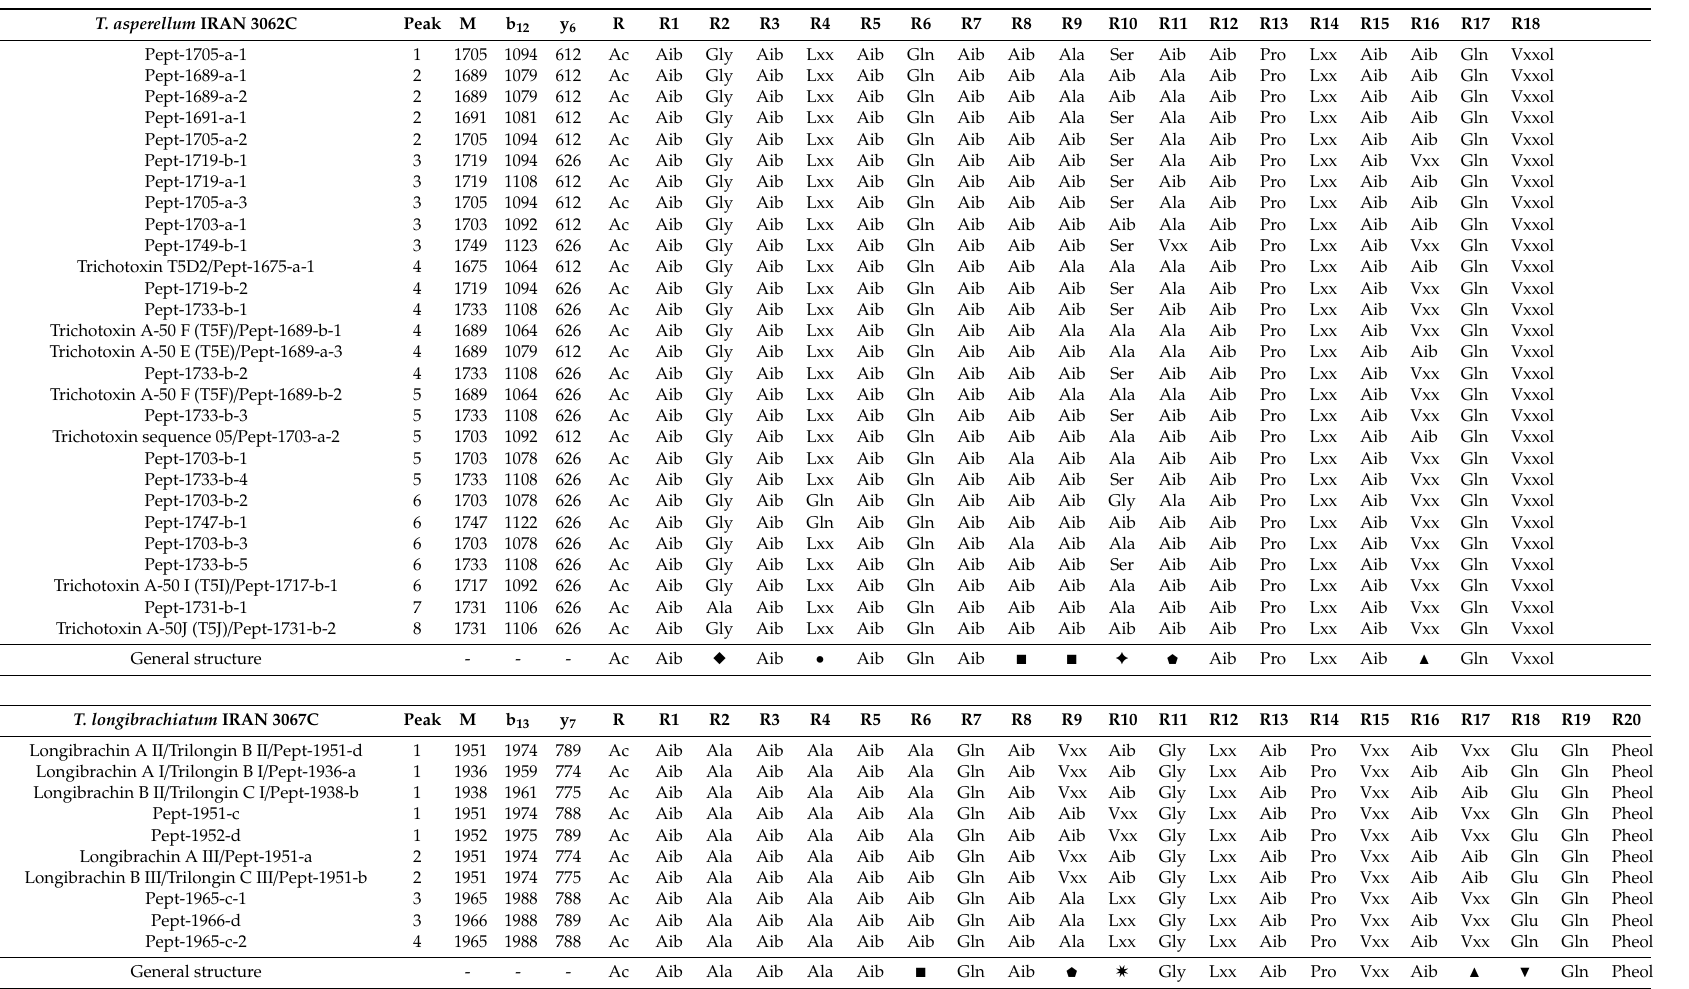
Table 1. Peptaibol sequences produced by T. asperellum IRAN 3062C and T. longibrachiatum IRAN 3067C [46].